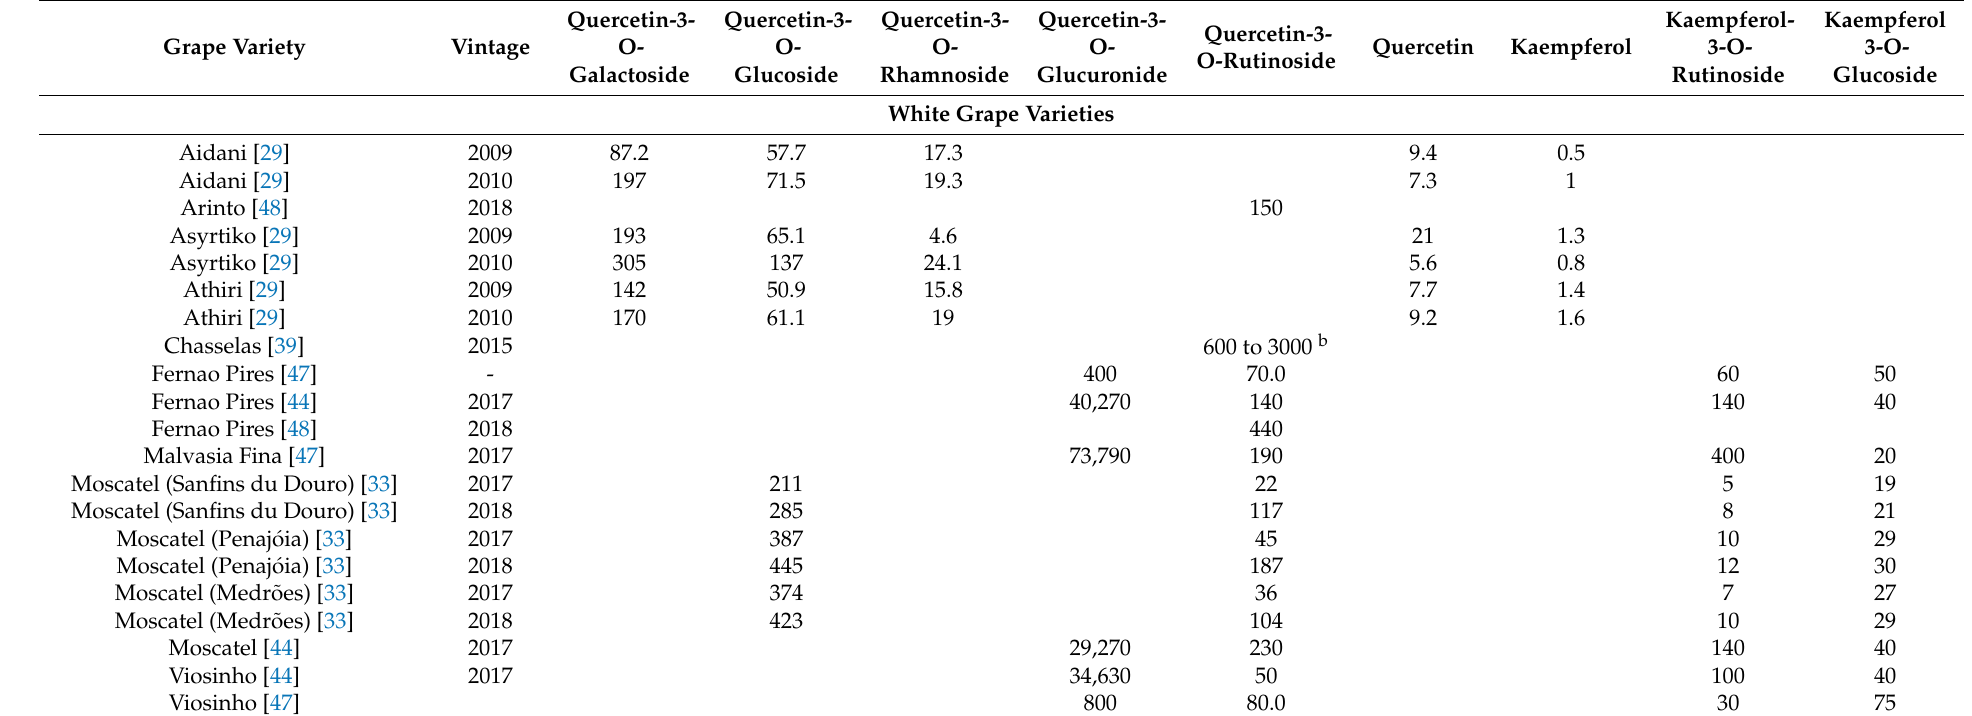
Table 5. Flavonol content quantified in different grape stem extracts (mg/kg